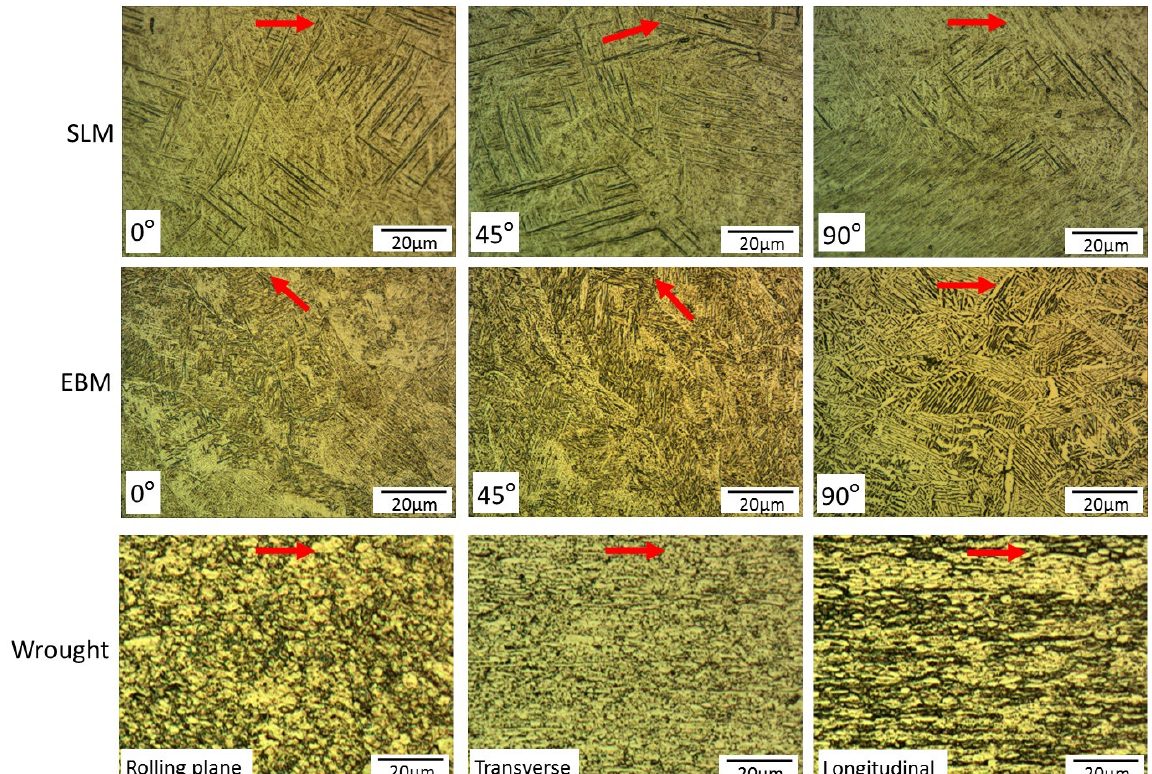
Figure 5. Optical micrographs of SLM, EBM and wrought samples. Note: build orientation for SLM and EBM (and rolling direction—wrought alloys) are indicated by the red arrows.